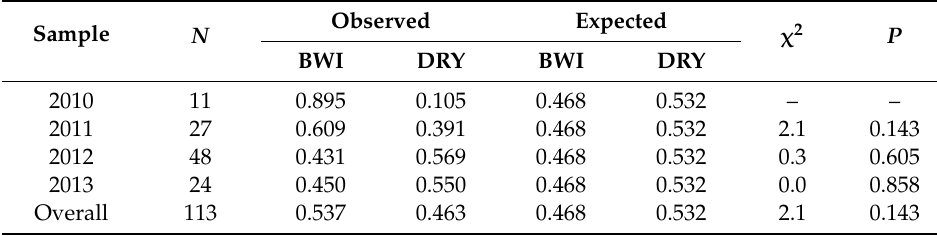
Figure 3. Summary of the Bayesian clustering results for the Matuwa translocated population assuming two admixed populations ( K = 2). Each individual is represented by a bar showing its estimated membership to a particular cluster (represent by different colours). Black lines separate samples from different source populations (Barrow Island and Dryandra) and collection years at the Matuwa translocation site. Table 3. Observed and the initial expected proportions of membership to each predefined cluster in samples taken from the Matuwa population. Observed proportions are based on mean Q-values from the STRUCTURE analysis of microsatellite data. Expected proportions are based on the number of individuals translocated from each source populations after individuals with known or assumed mortality were removed. For convenience, clusters have been labelled according to the source population they define (BWI = Barrow Island and DRY = Dryandra).